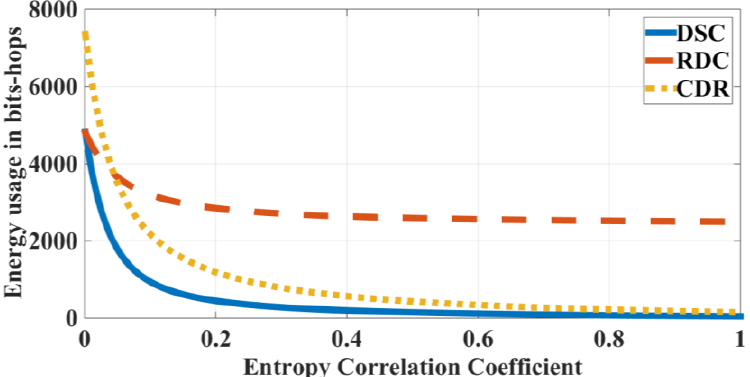
Figure 8. Energy expenditures for the DSC, RDC, and CDR schemes respectively to entropy correlation coefficients.